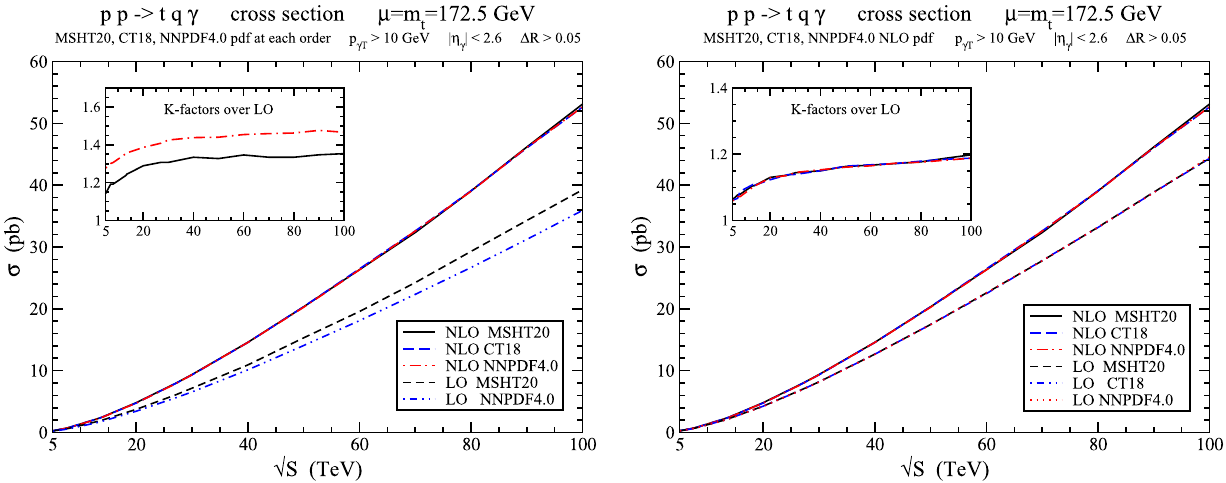
Fig. 1 The total cross sections at LO and NLO for tq γ production at pp colliders using various pdf sets. In the left plot we use NLO (LO) pdf for the NLO (LO) cross sections while in the right plot we use NLO pdf for all results